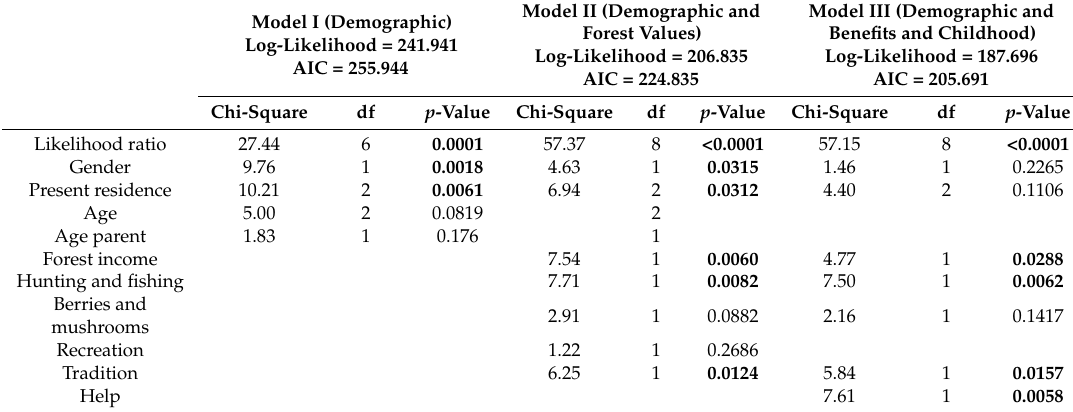
Table 3. Logistic regression analysis of the interest to take over as a function of demographic variables, benefits and aspects of respondents’